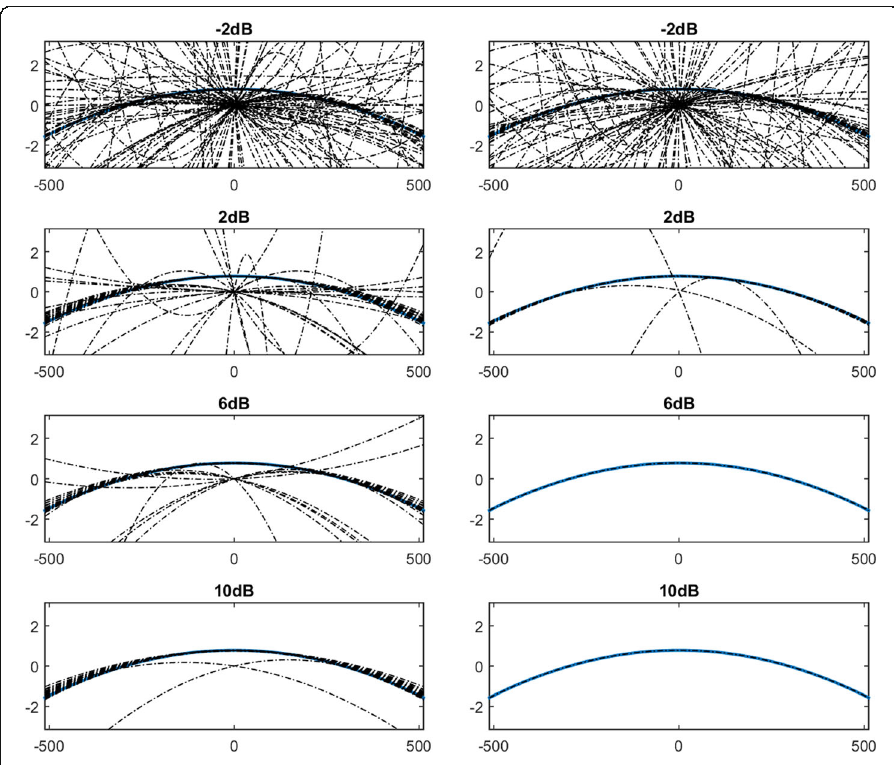
Fig. 9 Cubic phase signal with K / N =12% — 100 trials of the RANSAC procedure without (left) and with refinement (right column) for various SNRs: first row — − 2dB; second row — 2dB; third row — 6dB; fourth row — 10dB. Blue line — exact IF value; black lines —